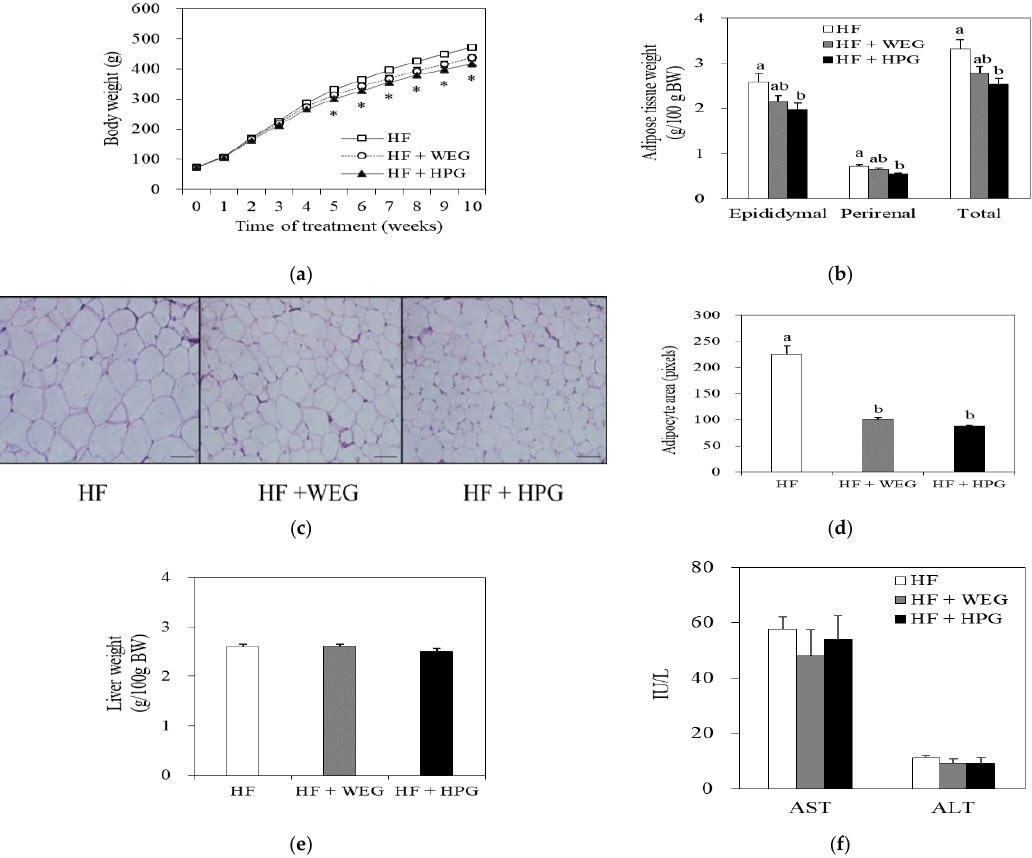
Figure 3. Effects of WEG and HPG on diet-induced obesity. ( a ) Body weight and ( b ) adipose tissue weight of rats fed WEG and HPG diets for 10 weeks; ( c ) Representative histological sections of epididymal adipose tissue; hematoxylin and eosin stain, scale bar = 100 µ m; ( d ) Average adipocyte size was presented as pixels; ( e ) Liver weight and ( f ) serum aspartate transaminase (AST) and alanine transaminase (ALT) levels. Values are expressed as mean ± SEM ( n = 9/group). * p < 0.05 compared to the HF group. a,b Mean values with unlike superscript letters are statistically different at p < 0.05. HF: high fat; WEG: hot water extract of ginger; HPG: high-hydrostatic pressure extract of ginger.